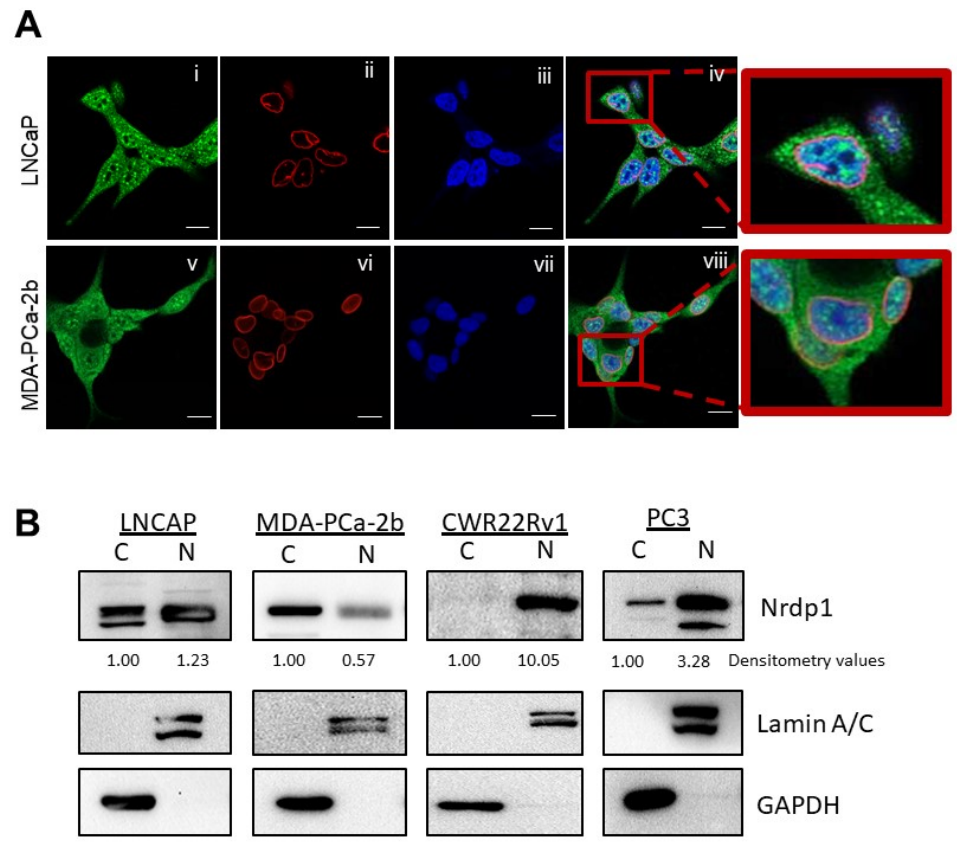
Figure 1. NRDP1 protein is expressed in the nucleus as well as the cytoplasm in prostate cancer cell lines. Confocal microscopy analysis of NRDP1 immunofluorescence staining in LNCaP and MDA-Pca-2b cell lines ( A ) revealed that NRDP1 is located in both the nucleus and cytoplasm of prostate cancer cells. Localization of NRDP1 in the nucleus of prostate cancer cells has not previously been reported. NRDP1 appeared as distinct puncta in the cytoplasm and nucleus. In LNCaP cell ( i – iv ), more puncta were observed and were brighter compared to those observed in MDA-Pca-2b cells ( v – viii ) indicating higher levels of expression in LNCaP. Subcellular fractionation followed by western blot ( B ) confirmed that NRDP1 is located in the nucleus of LNCaP and MDA-Pca-2b cells as well as CWR22Rv1 and PC3 cells. Higher levels of nuclear NRDP1 relative to cytoplasmic NRDP1 were observed in CWR22Rv1 and PC3 cell lines (both castration resistant cell lines, cytoplasmic:nuclear NRDP1 ratios were 1:10.05 and 1:3.28, respectively) compared to LNCaP and MDA-Pca-2b cell lines (both androgen sensitive cell lines, 1:1.23 and 1:0.57, respectively). Detailed information about Western Blot can be found at supplementary materials. Green = NRDP1, Red = nuclear lamin, Blue = DAPI (nucleus) scale bar = 10 µ m. Table 2. Logistic regression models of PSA failure by Marker Expression.